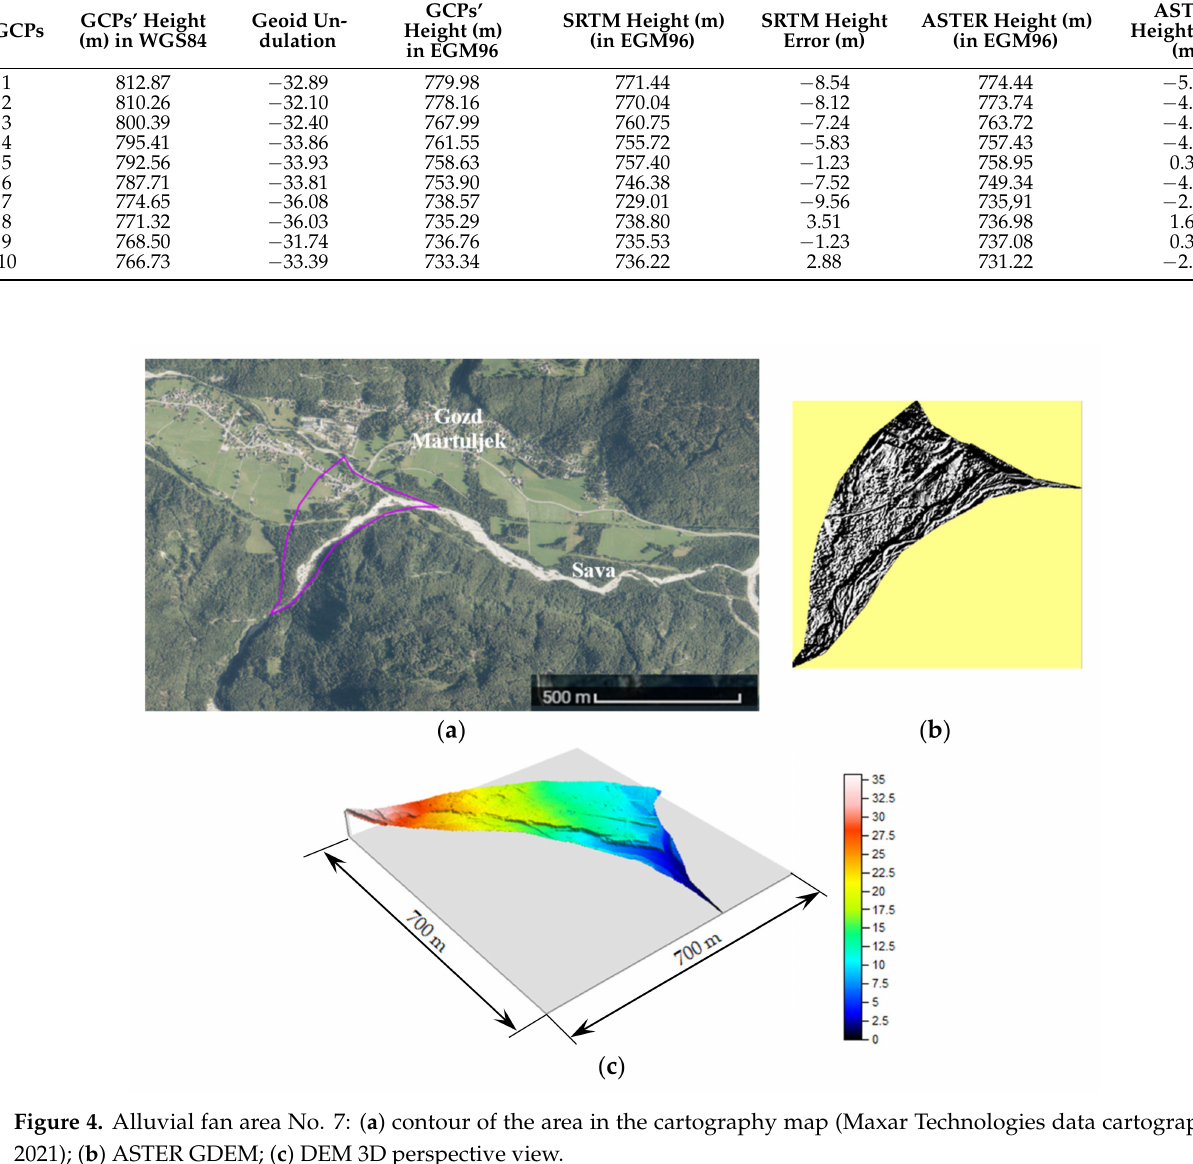
Table 1. Error in ASTER GDEM and SRTM with respect to the GCP-derived height in torrential fans No. 7.